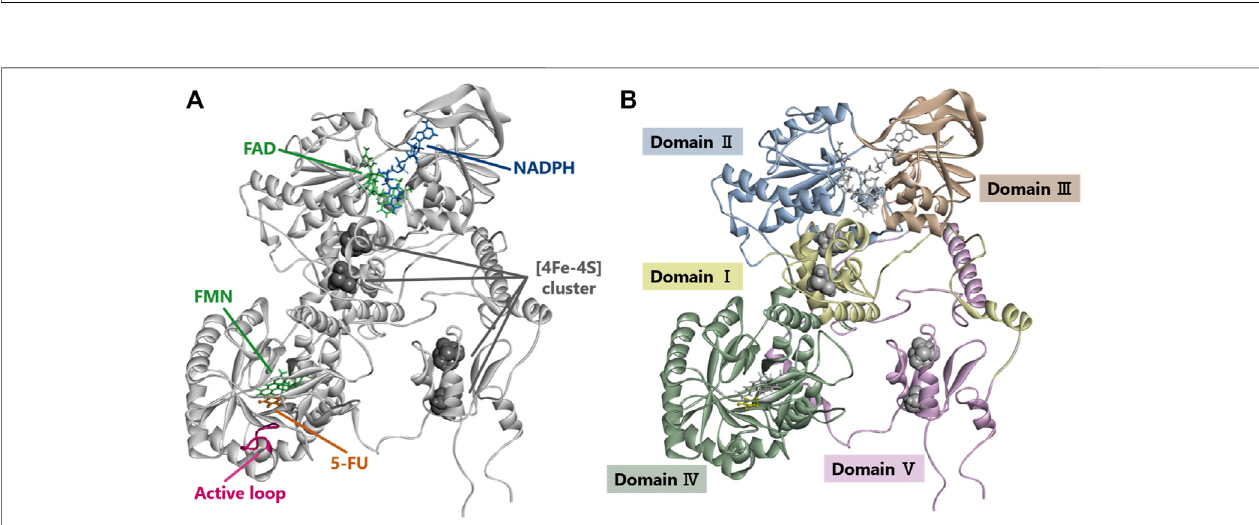
FIGURE5| Dihydropyrimidinedehydrogenase (DPD) structuralanalysis. (A) Diagramshowingoverall structure ofhuman DPD. (B) Diagram showing each domain of human DPD.